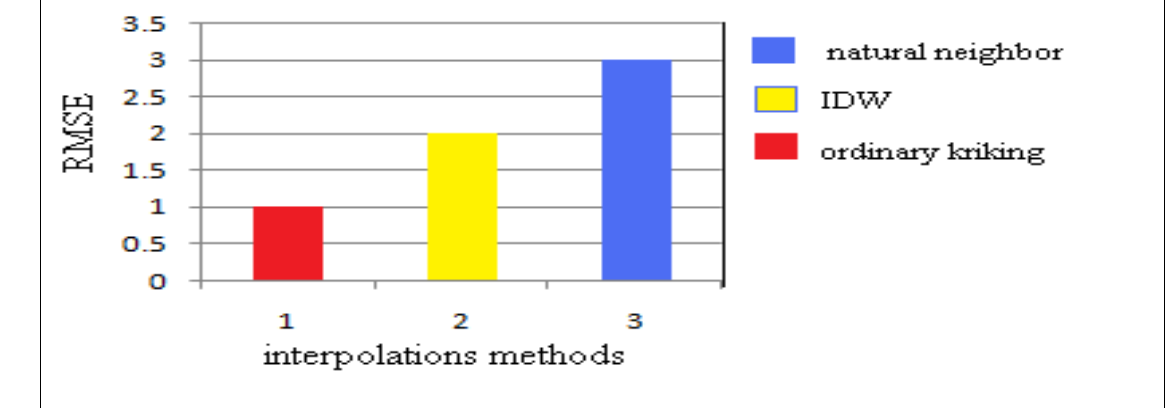
Fig. 11 : A plot representing the Average RMSE for each interpolation